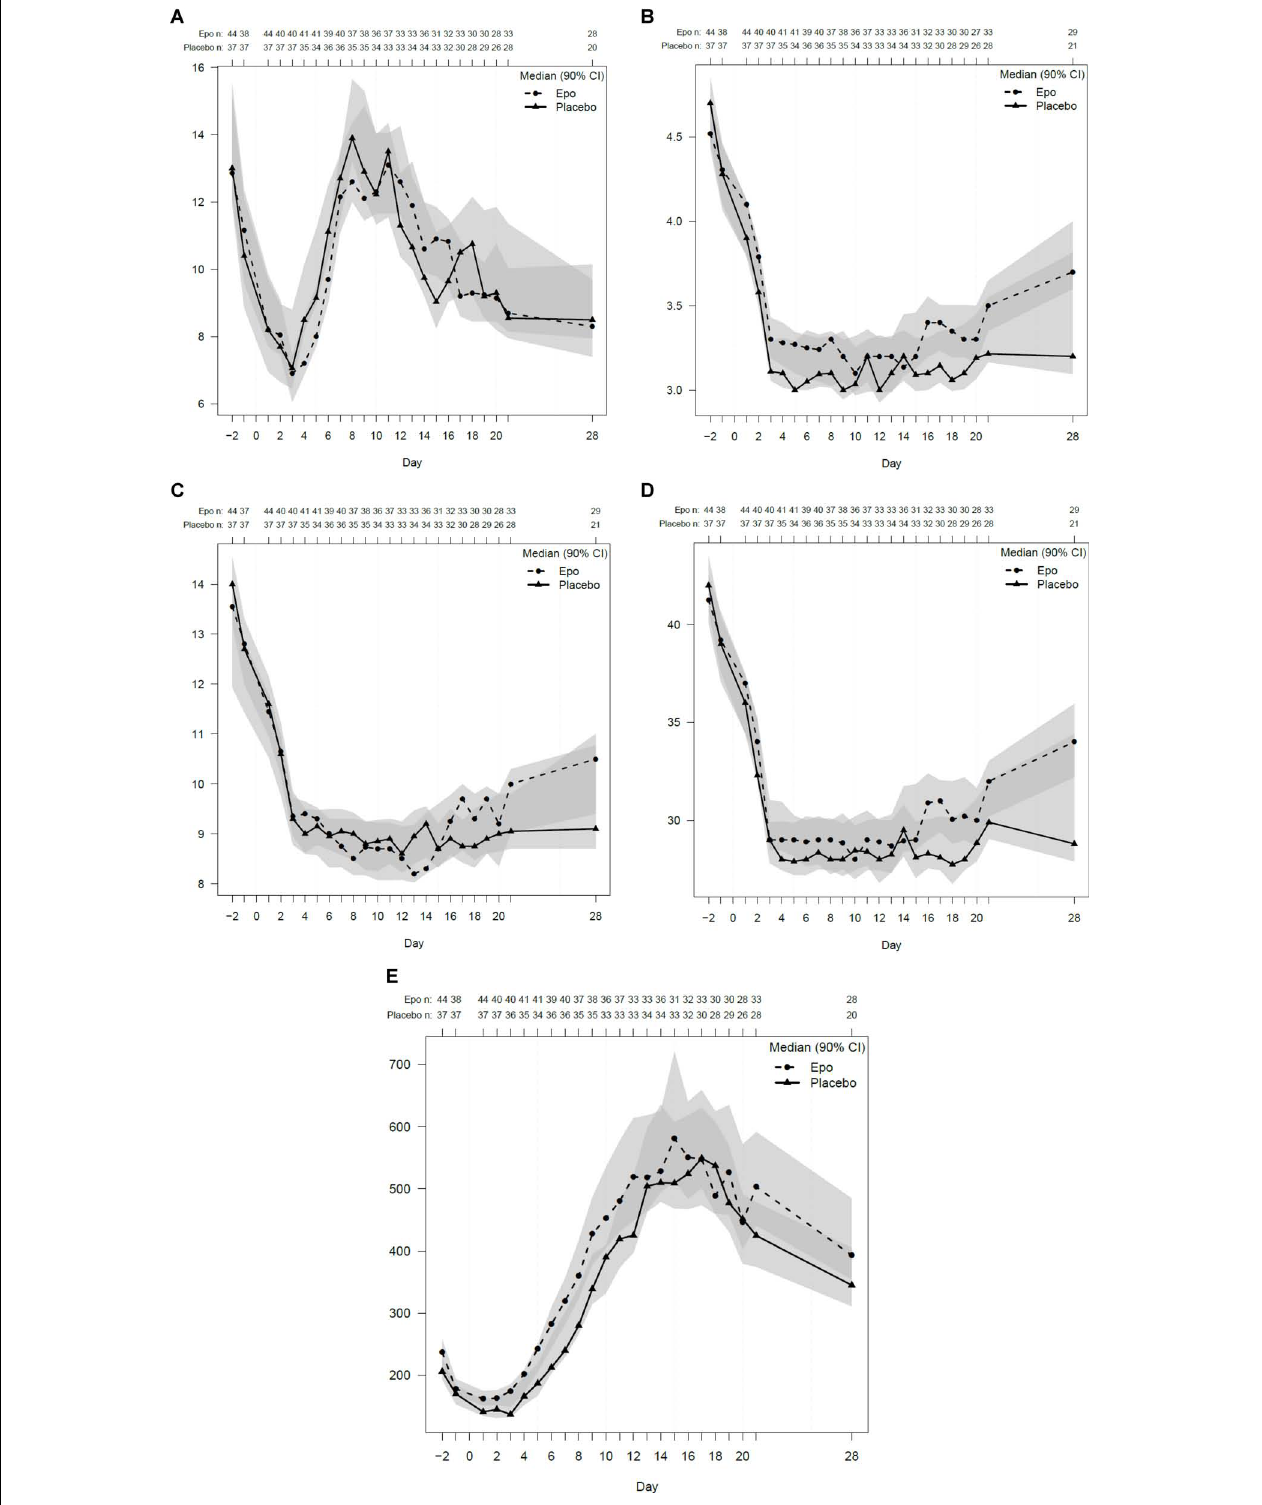
FIGURE 6 | Laboratory control results. Legend: Laboratory control data are displayed in SI units’ median with two-sided 90% confidence intervals. (A) White Blood Cell Count (/nl). (B) Red Blood Cell Count (/pl). (C) Hemoglobin (g/l). (D) Hematocrit (%). (E) Thrombocytes (/nl).